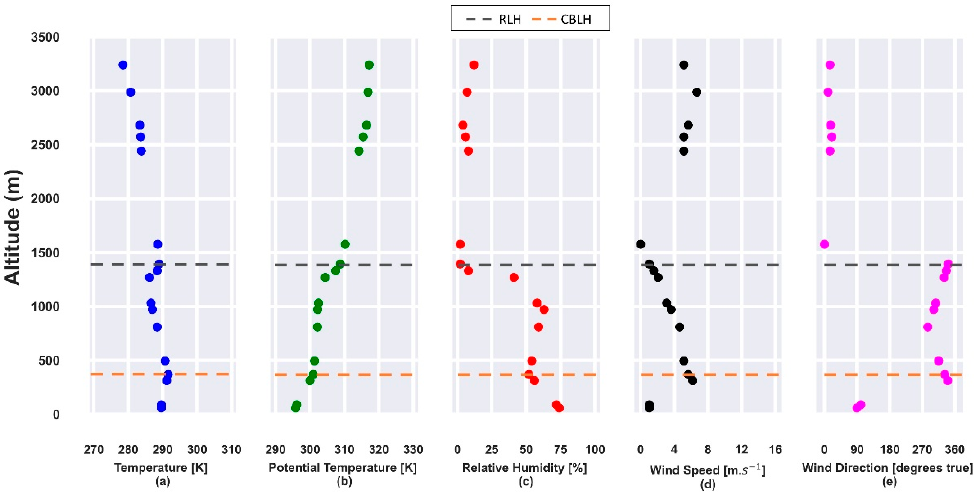
Figure 13. Atmospheric parameters obtained from radiosonde data on 24 July 2019, at 12:00 UTC. ( a ) Temperature [K]; ( b ) potential temperature [K]; ( c ) relative humidity [%]; ( d ) horizontal wind speed [m·s − 1 ]; ( e ) wind direction [degrees true]. The gray and orange dotted lines represent the RLH and CBLH, respectively.